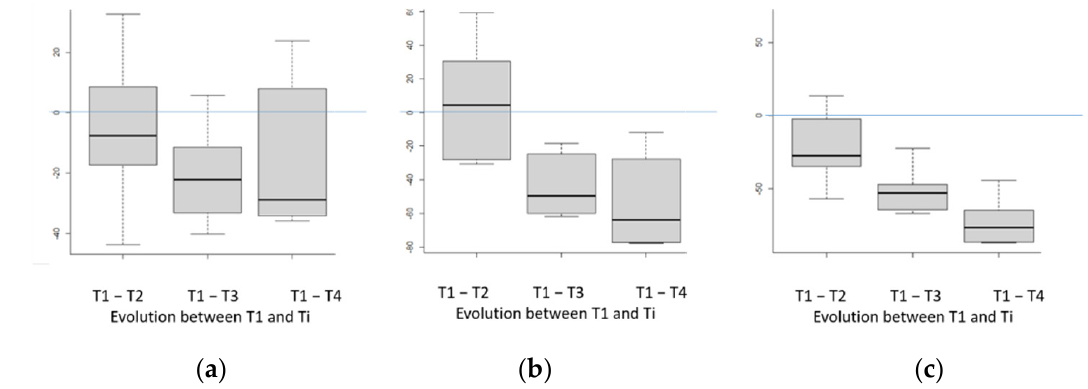
Figure 5. Kinetic of evolution for ( a ) shear force, ( b ) 20% compression shear, ( c ) 80% compression shear) depending on ageing time for raw meat expressed as a relative value of the content on day 7. T1, T2, T3 and T4 correspond to the different ageing times (respectively 7, 16, 35 and 60 days). Box-plot explanation: the central value represents the median; the edges of the rectangle are the quartiles and the extremities are calculated using 1.5 times the interquartile range.